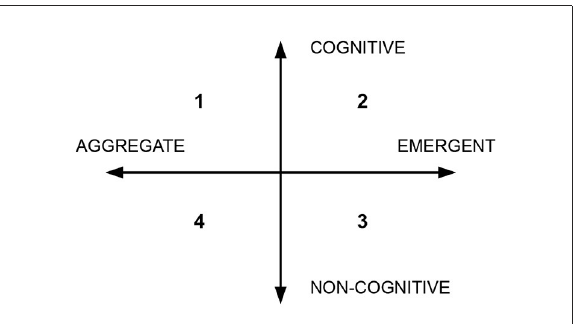
FIGURE1 Conceptual space proposed by Poirier and Chicoisne (2008) to classify the relation between two entities in a cognitive system.